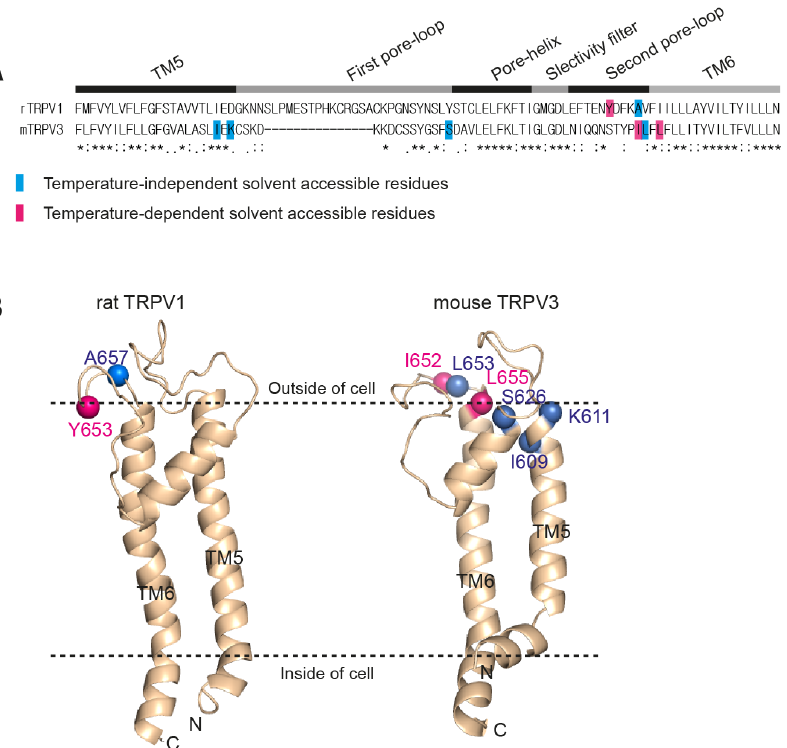
Figure 5. Location of temperature-dependent accessible residues. (A) Sequence alignment of pore domains of rat TRPV1 and mouse TRPV3. Predicted structural domains are indicated above. Residues with temperature-independent accessibility are highlighted in cyan and residues with temperature-dependent accessibility are in pink. (B) Homology models of pore domains. Same color coding was used as the above.